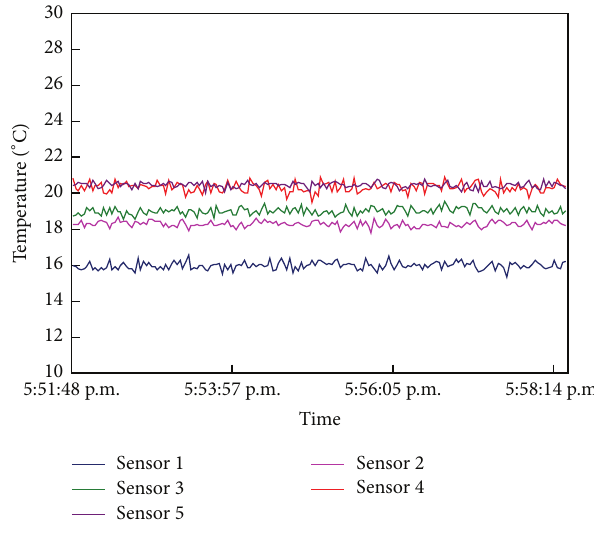
Figure 7: Duration curve of temperature sensors.